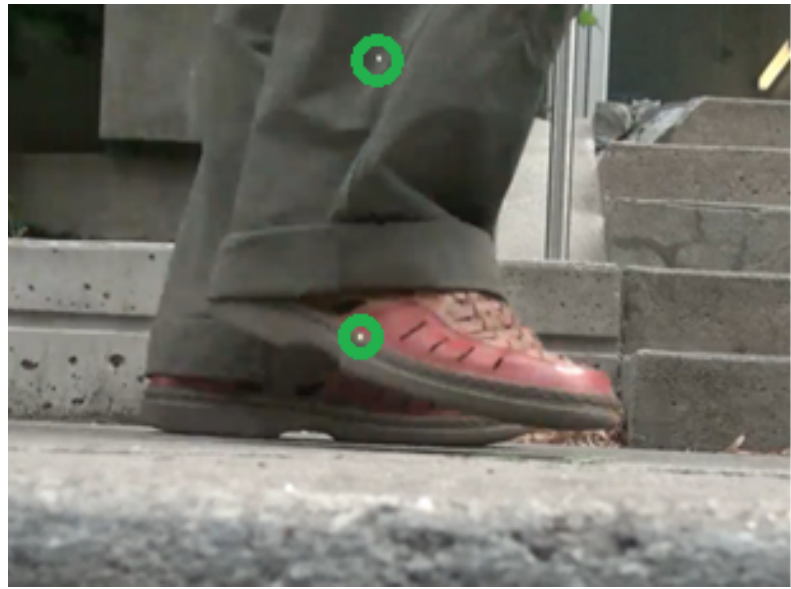
Figure 4. This image shows an example of a frame where the laser dots are projected onto the pedestrian’s foot. The laser dots are marked with a green circle. The distance between the center of these two dots in the picture is equal to the fixed distance between the two laser pointers on the